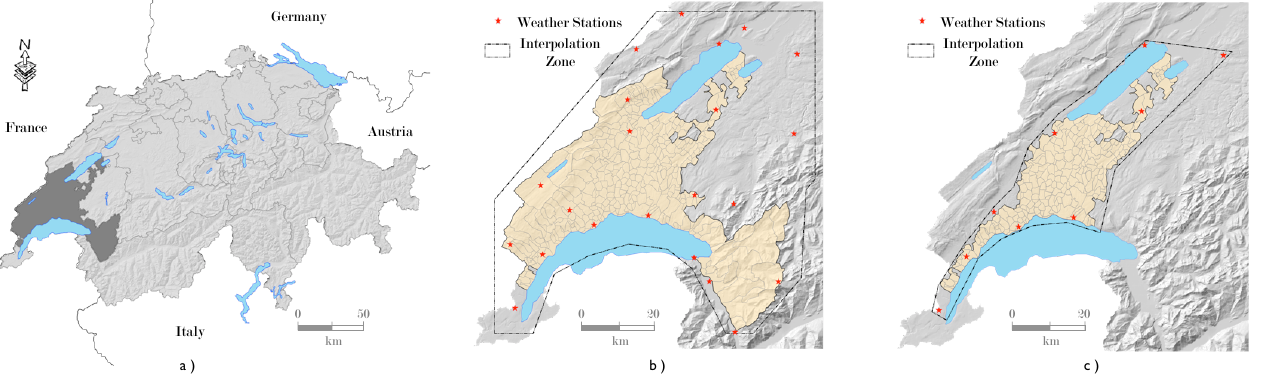
Fig. 1. Maps of the canton of Vaud: (a) map showing the geographic location of Vaud in Switzerland, (b) the canton of Vaud and its 368 municipalities, with the Jura mountains to the west, the Alps to the East and the Lake of Geneva to the south. The 22 weather stations used for this study are shown, as well as the interpolation zone. Finally, (c) shows a confined and more simple interpolation zone excluding the complex alpine region and the